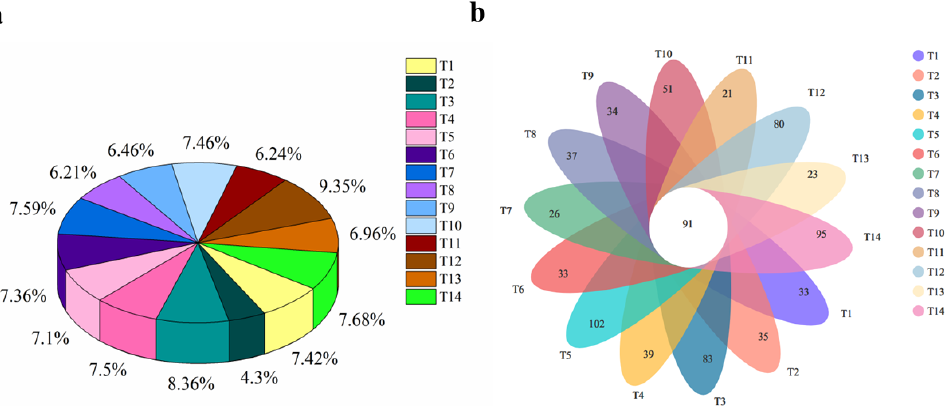
Figure 2. Number of fungal OTUs in soil samples from different aged apple orchards. ( a ) Proportion of total OTUs in different aged orchards; ( b ) Number of unique OTUs in different aged orchards.